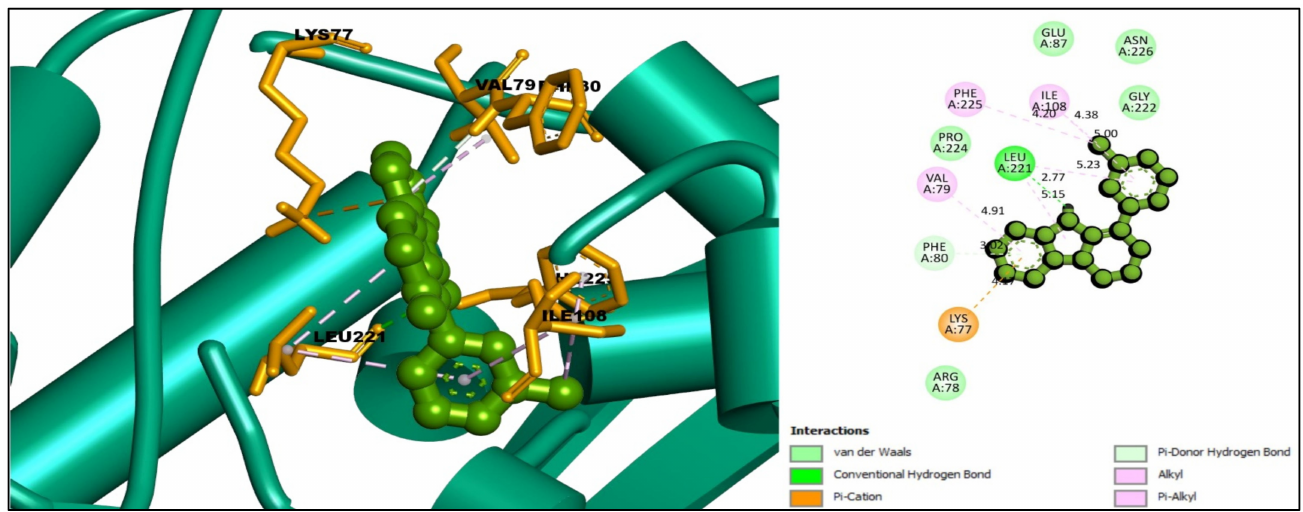
Figure 4. Interaction between the compound CID: 198912 and thymidylate synthase. The left side represents 3D, and the right side represents 2D complex